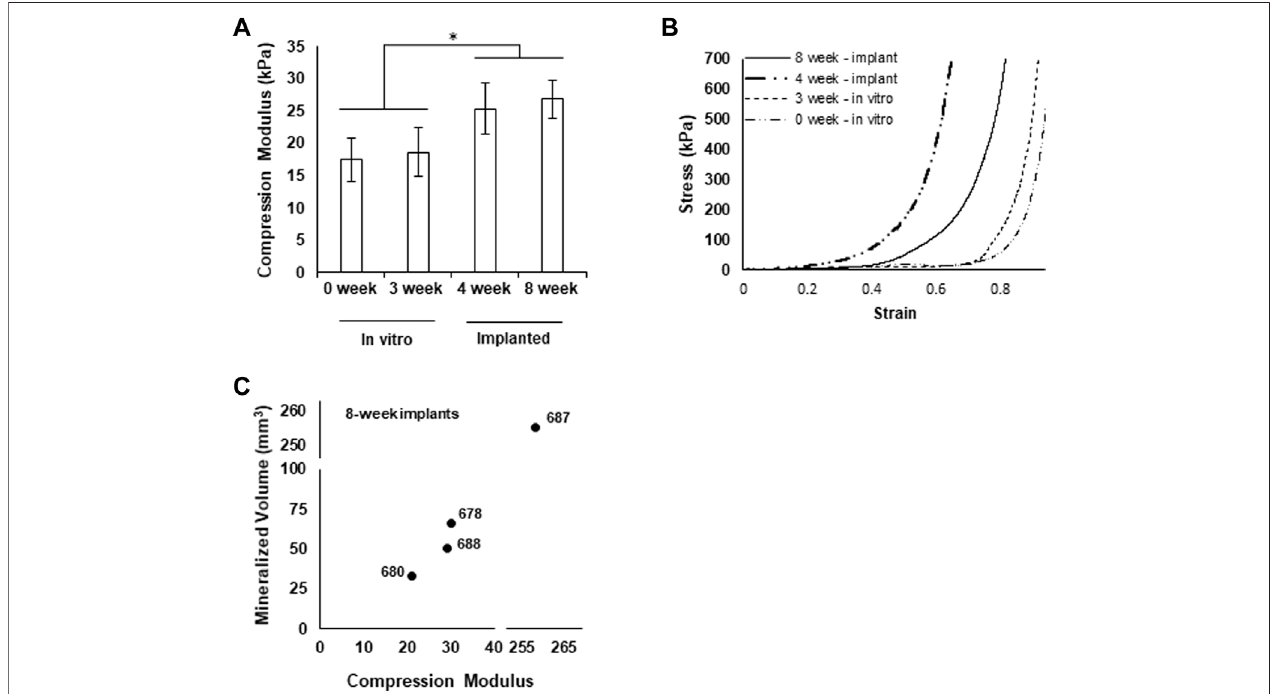
FIGURE 7 | Grafts exhibit increased mechanical integrity after implantation. (A) Compression modulus of grafts at each experimental phase, * p < 0.05. (B) Representativestress-straincurvesforeachexperimentalgroup(4 weeksgraft682,8 weeksgraft678.) (C) Mineralizedvolumeofgraftsexplantedafter8 weeksplotted against the respective compression